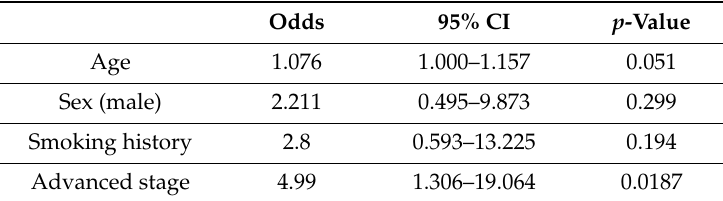
Table 3. Multivariate analysis of clinical factors association of with high PGE-MUM. The effects of age, sex, smoking history, and advanced stage on PGE-MUM levels were examined.